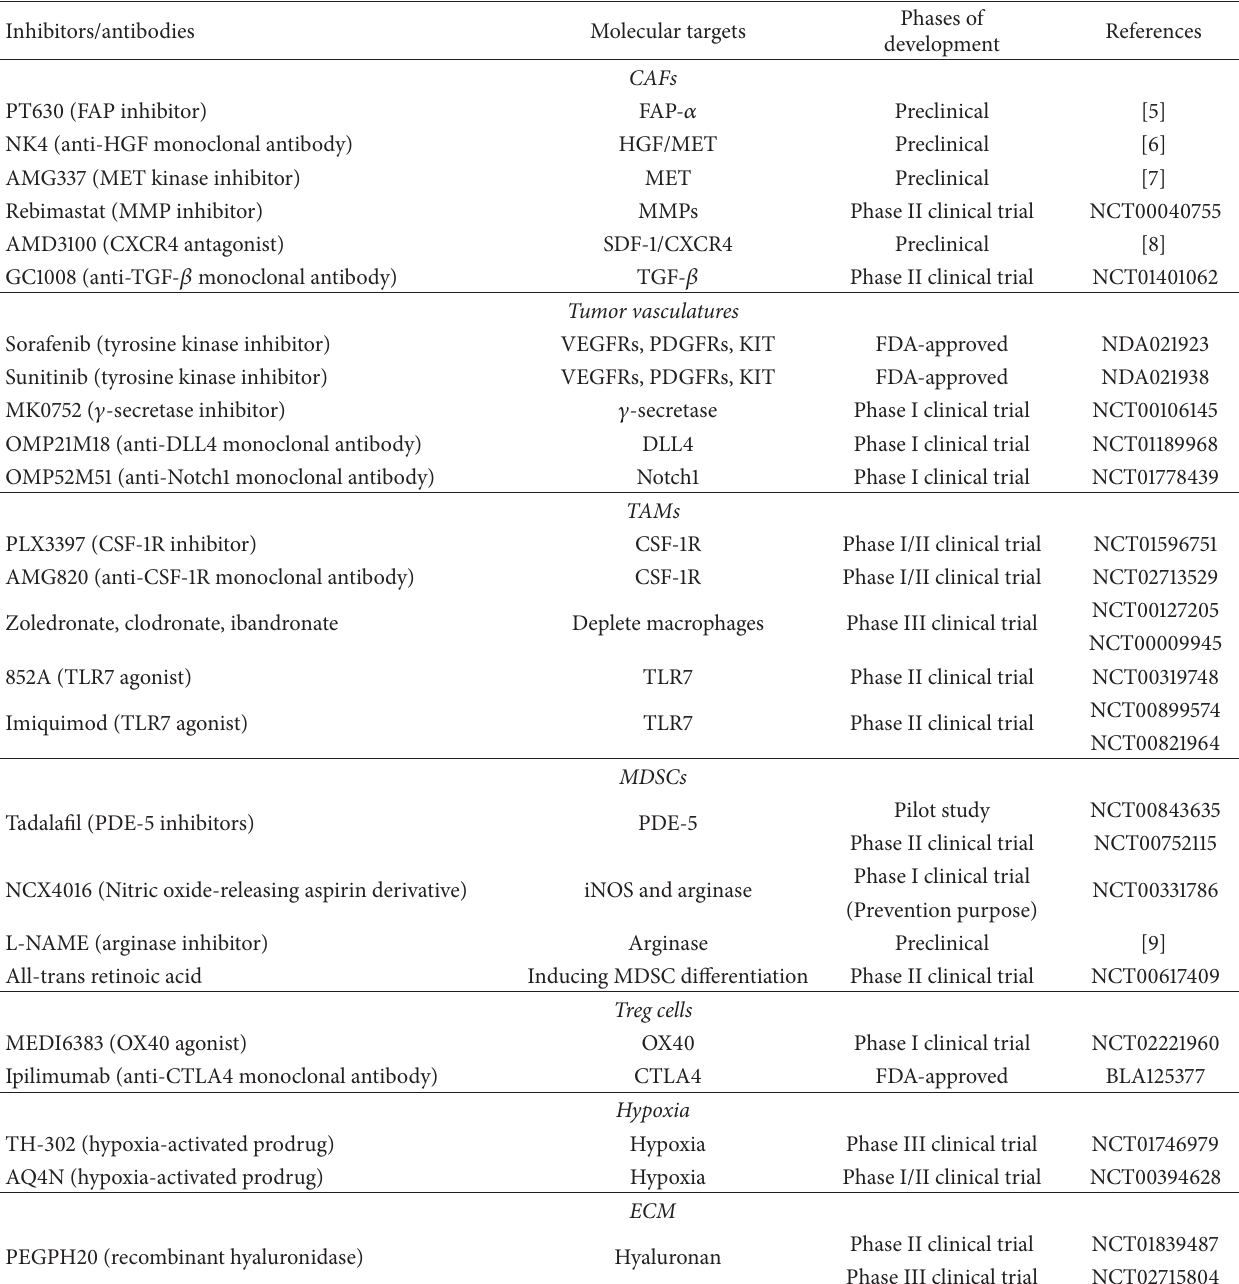
Table 1: Strategies of targeting the CSC niches for cancer treatment and their respective development